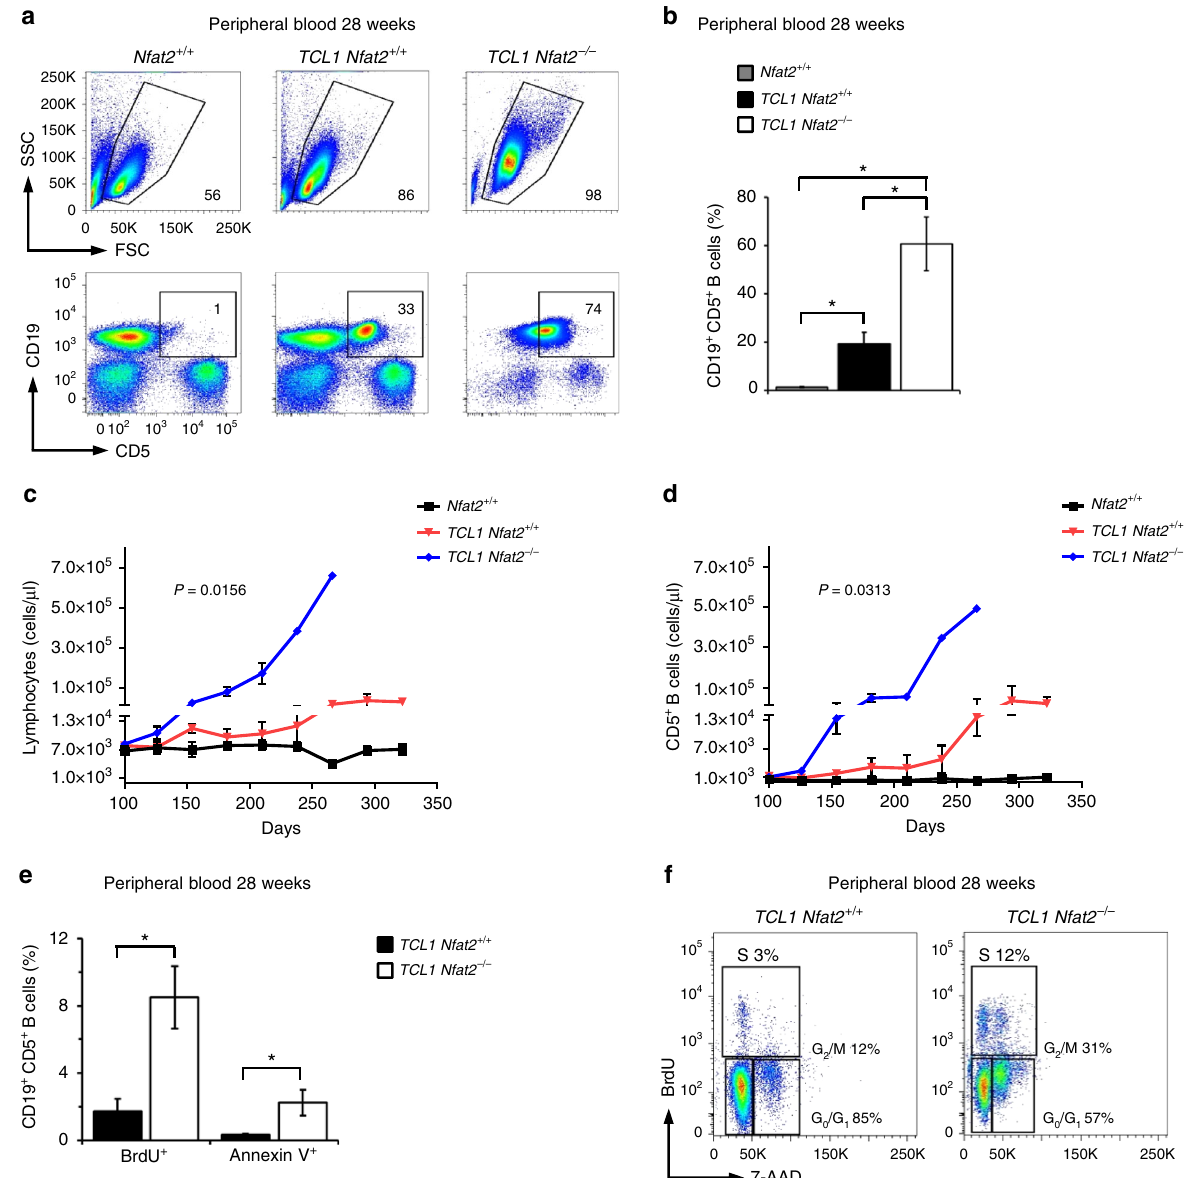
Fig. 2 Nfat2 deletion in E µ -TCL1 mice leads to signi fi cant acceleration of disease. a Flow cytometric analysis for CD19 + CD5 + CLL cells of the peripheral blood of one representative mouse for the indicated genotypes at an age of 28 weeks. b Statistical analysis of the fl ow cytometry data from a . n = 5 animals per group were analysed (Welch ’ s t -test, Mean ± S.E.M., * P < 0.05). c Absolute lymphocyte count of Nfat2 +/+ ( n = 5), TCL1 Nfat2 +/+ ( n = 10) and TCL1 Nfat2 − / − ( n = 10) mice. Peripheral blood was harvested every 4 weeks and samples were analysed using an Advia 120 haematology analyser (Paired Wilcoxon test, Mean ± S.E.M.). d Expansion of CD19 + CD5 + B cells in the peripheral blood of Nfat2 +/+ ( n = 5), TCL1 Nfat2 +/+ ( n = 10) and TCL1 Nfat2 − / − ( n = 10) mice assessed by fl ow cytometry at the indicated time points (Paired Wilcoxon test, Mean ± S.E.M.). e Proliferation and apoptosis of CD19 + CD5 + B cells in the peripheral blood of 28-week-old mice of the indicated genotypes ( n = 5 per group). Mice were injected with 10 mM BrdU i.p. and peripheral blood cells were harvested after 48 h. CD19 + CD5 + B cells were stained with BrdU and Annexin V antibodies and measured by fl ow cytometry ( n = 5) (Welch ’ s t -test, Mean ± S.E.M., * P < 0.05). f Cell cycle analysis of CD19 + CD5 + B cells in the peripheral blood of 28-week-old mice of the indicated genotypes ( n = 5 per group). Mice were injected with 10 mM BrdU i.p. and peripheral blood was harvested 24 h after injection. CD19 + CD5 + B cells